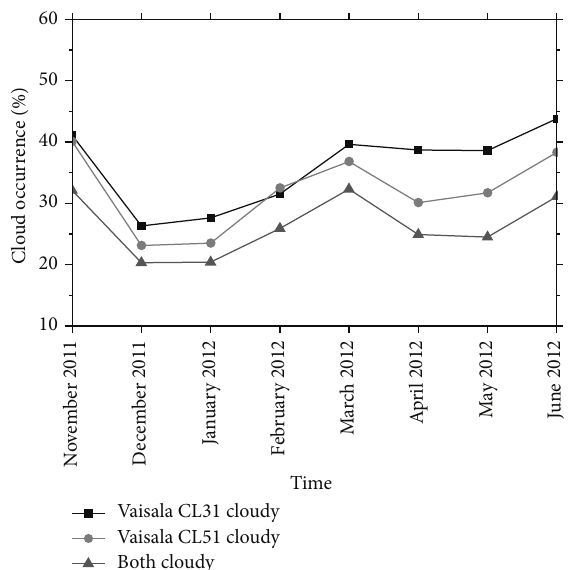
Figure 1: Monthly cloud occurrence for the period November 2011 to June 2012, as derived from Vaisala ceilometers CL31 and CL51.